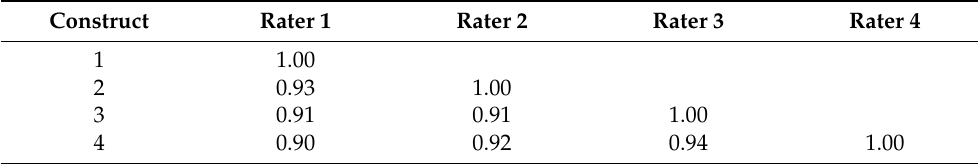
Table 4. Inter-rater